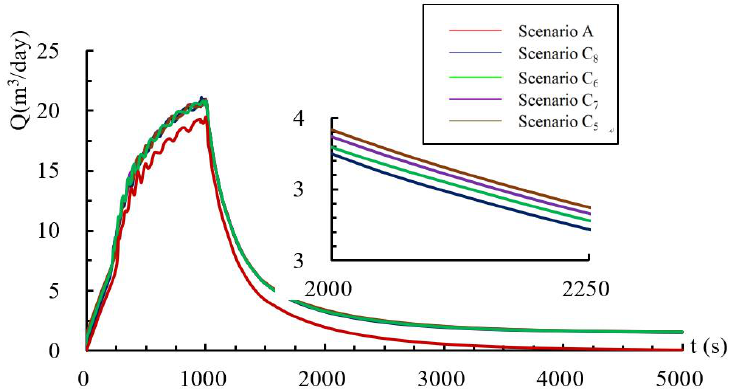
Figure 10. Spring hydrographs with pumping at different wells.